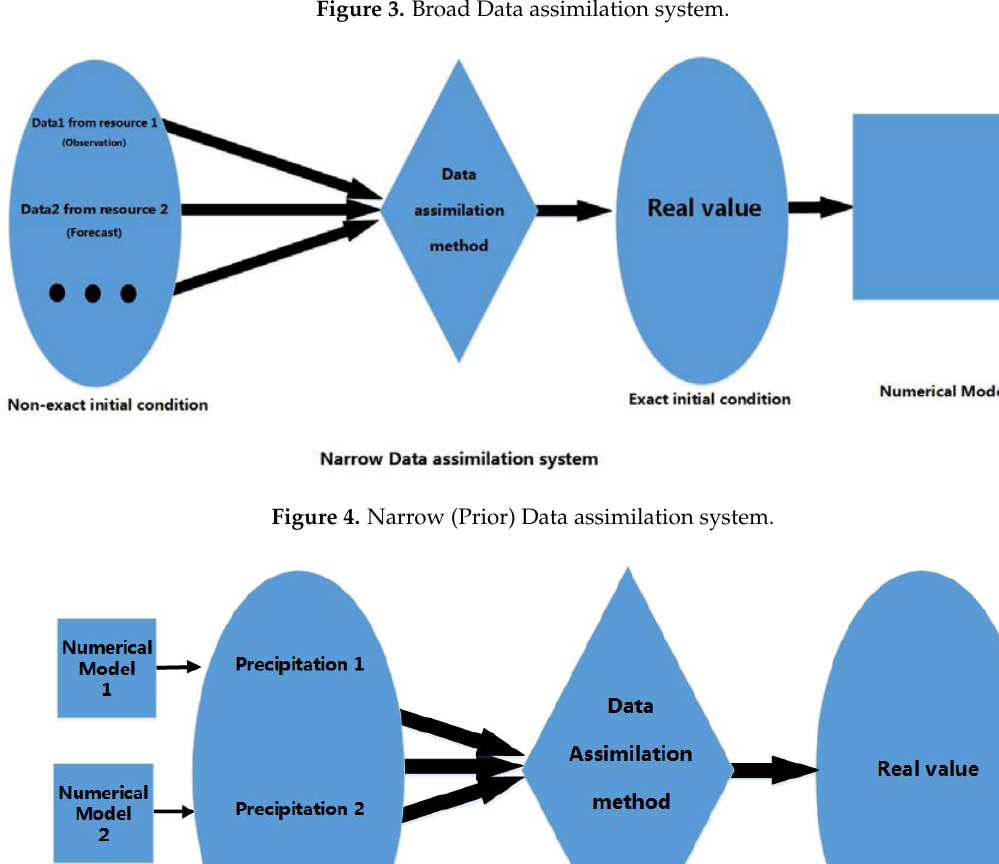
Figure 3. Broad Data assimilation system. Information 2018 , 9 , x